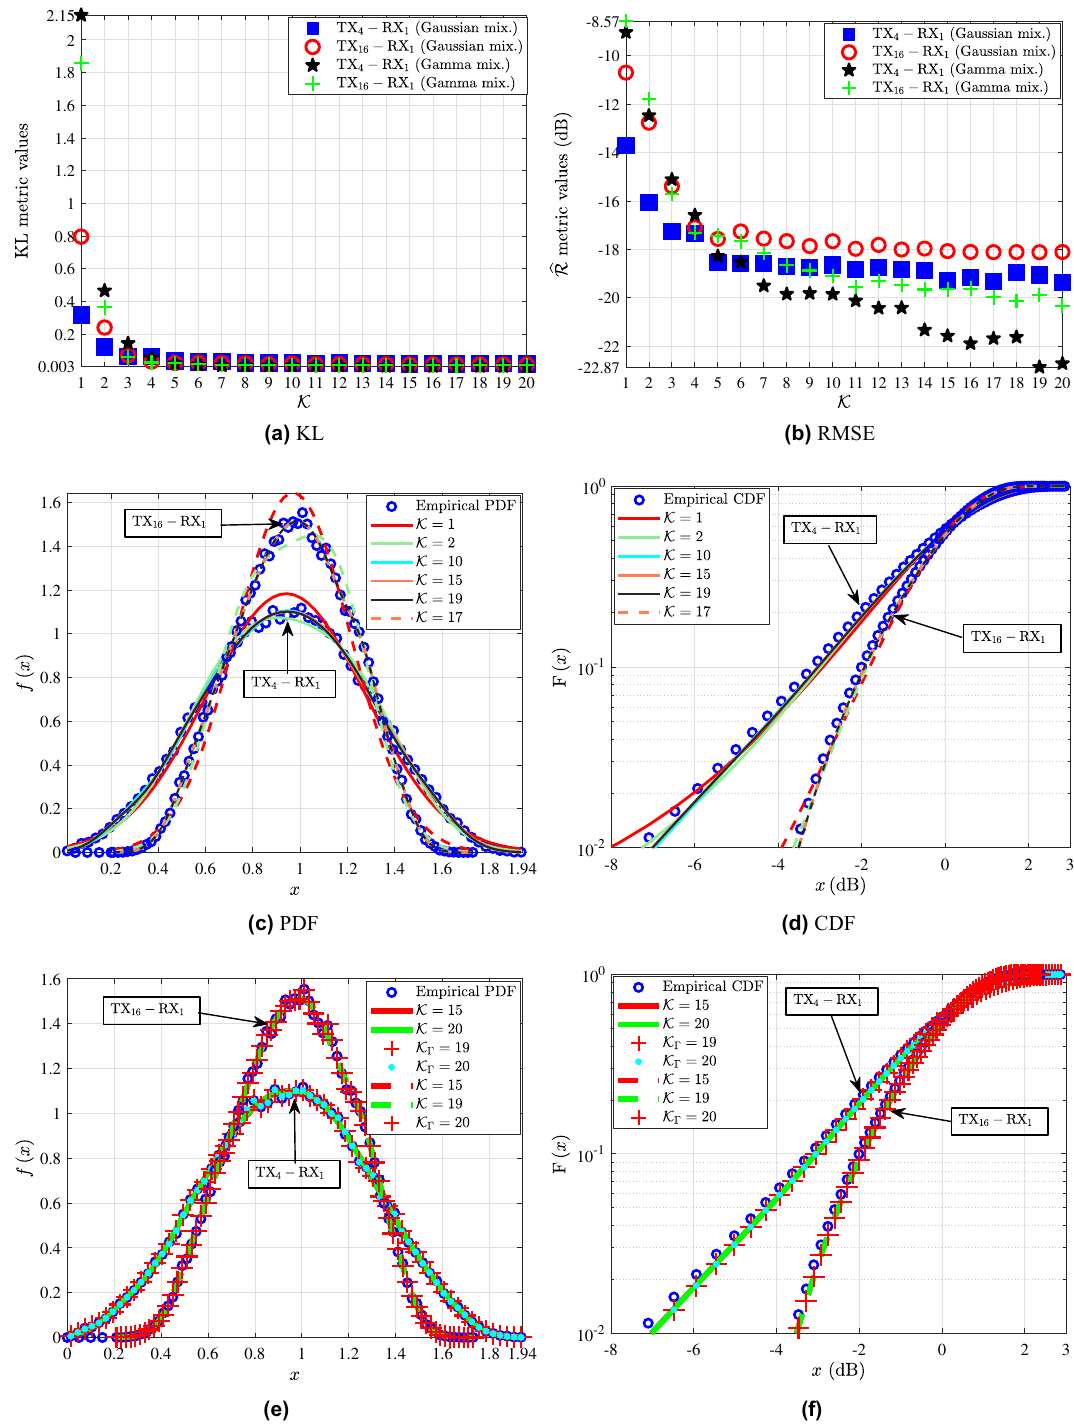
RX 1 : ( a ) KL and ( b ) RX 1 and TX 16 R metrics for different values of K for the GMs and MGs. Figure 3. TX 4 − − ( c ) Fitting of the PDF and ( d ) CDF analytical GM expressions to the empirical channel gain data. ( e ) Fitting of the PDF and ( d ) CDF of the best fitting analytical GM and MG expressions to the empirical channel gain (cid:31)